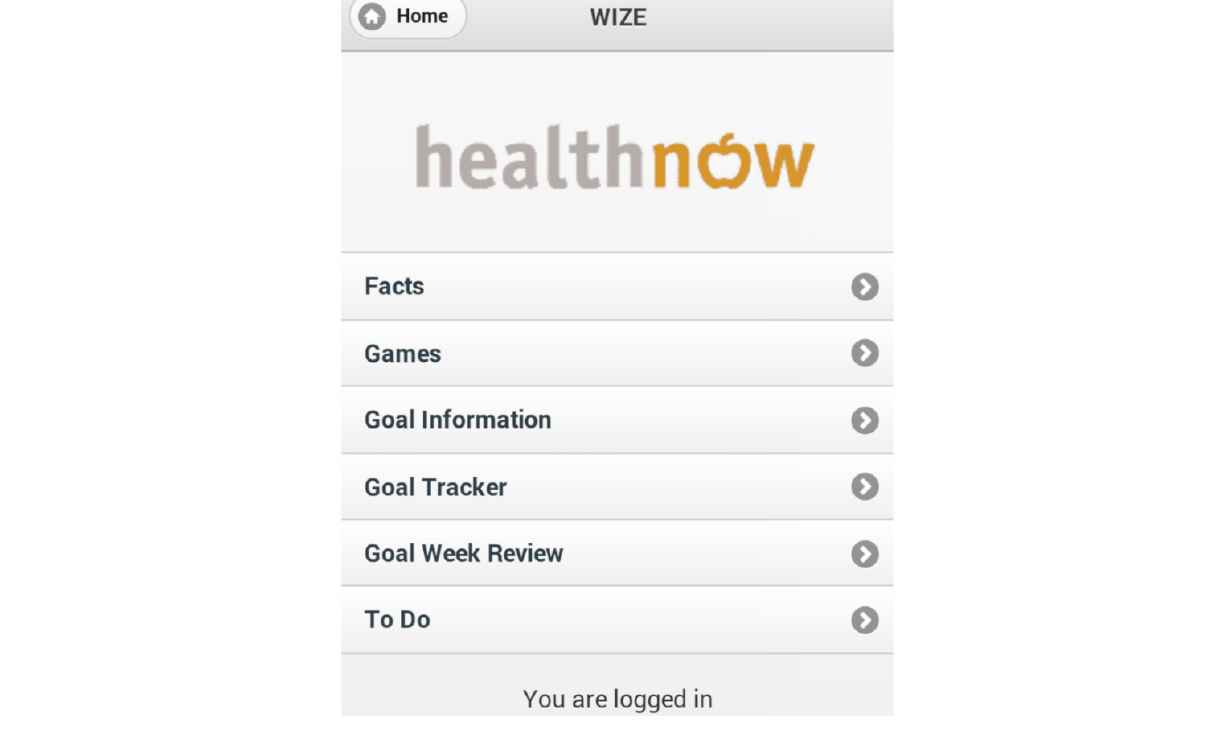
Figure 1. Screenshot of app illustrating home page.